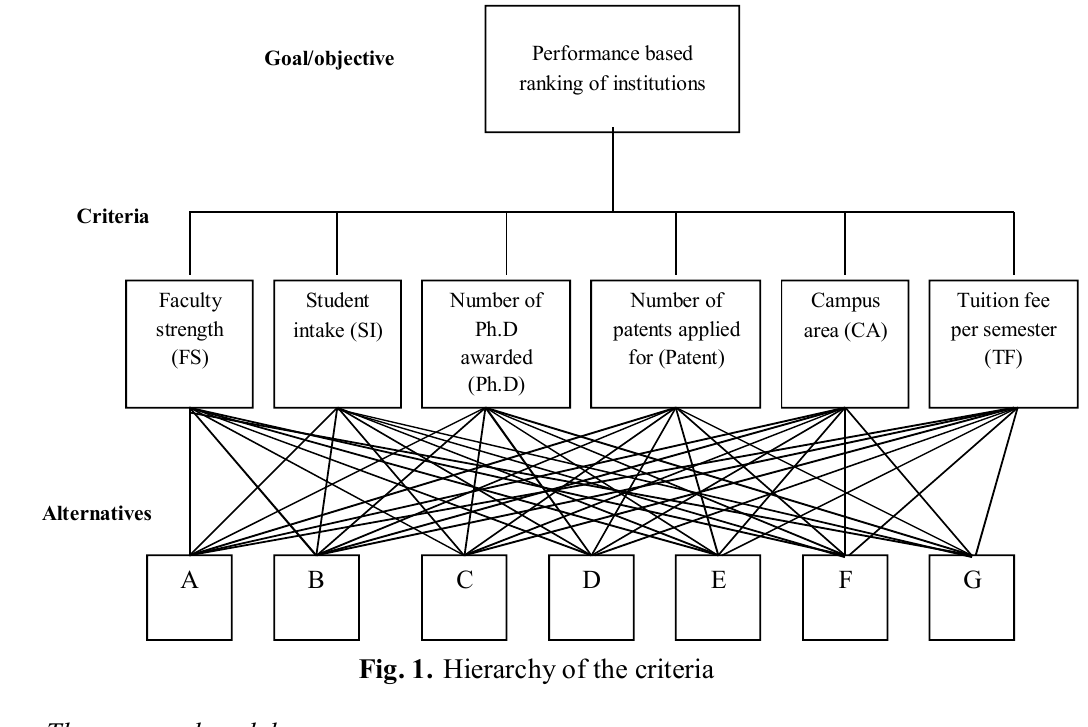
Fig. 1. Hierarchy of the